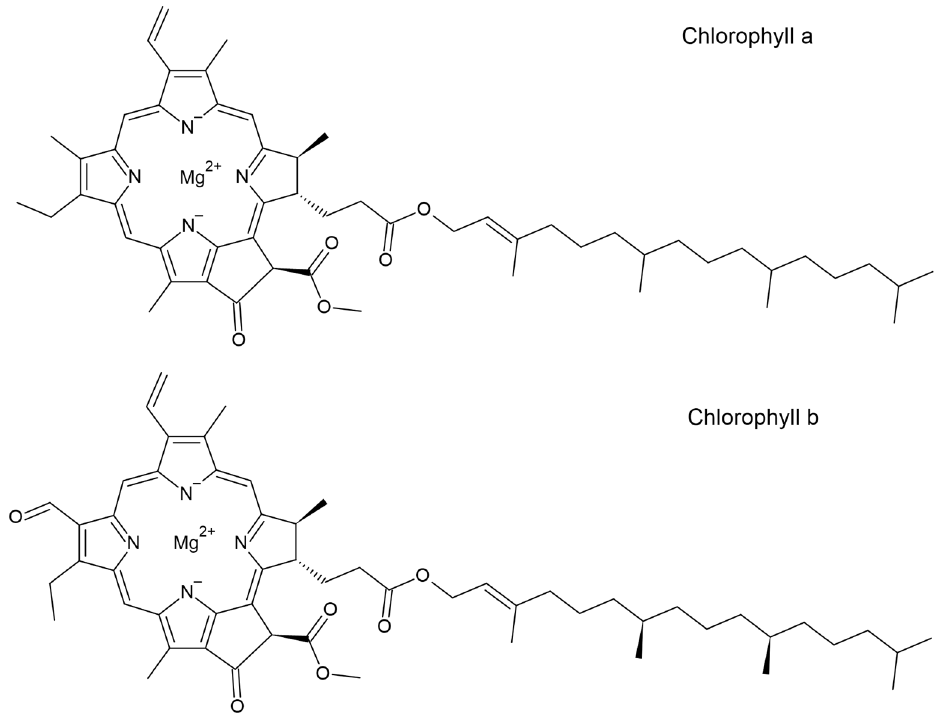
Figure 1. Structural formula of chlorophyll. Top: Chlorophyll a. Bottom: Chlorophyll b.